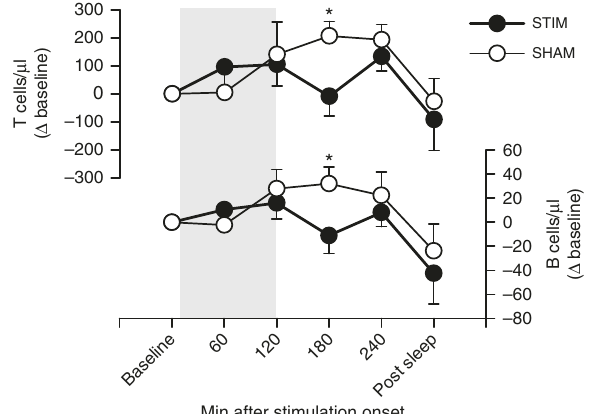
Fig. 3 Impact of auditory SO stimulation on lymphocyte counts. Means ( ± s.e.m.) of circulating T and B cell numbers (shown as difference from baseline). Gray area represents the 120-min stimulation period. * p < 0.05 for pairwise comparisons between the Stimulation condition (STIM, black) and the Sham condition (SHAM, white) with Wilcoxon tests, two-sided. n =